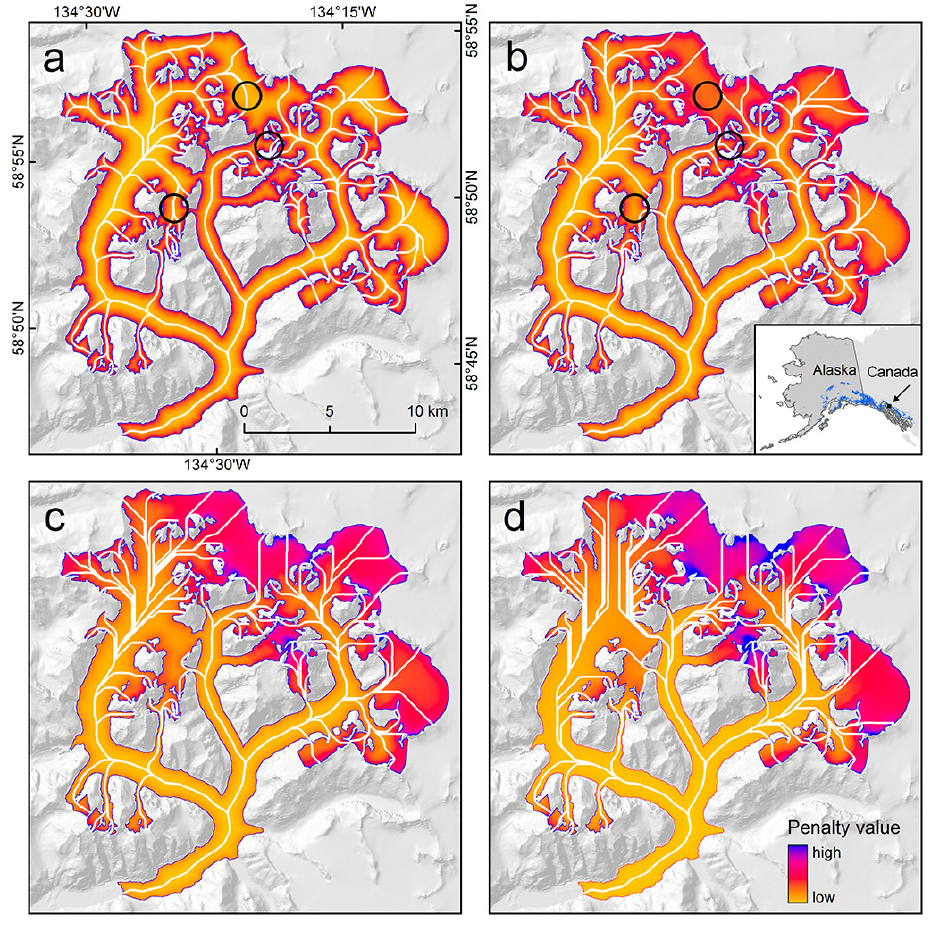
Fig. 4. Selected penalty grids of Gilkey Glacier and corresponding centerlines, using a constant a value of 4.25, but varying b . (a) Initial cost grid with b = 3 . 5. The penalty values strongly decrease towards the center of the branches. There is a subsidiary decline from higher to lower elevations. The black circles indicate centerlines that take implausible routes with significant upslope flow. (b) The penalty grid with b = 3 . 7 (i.e., 1b = 0 . 2). The initially wrong centerlines now take the correct routes; however, other centerlines have partially deviated from their expected courses. (c) b = 3 . 9 ( 1b = 0 . 4). (d) b = 4 . 1 ( 1b = 0 . 6). Many centerlines are cutting corners, especially in higher glacier